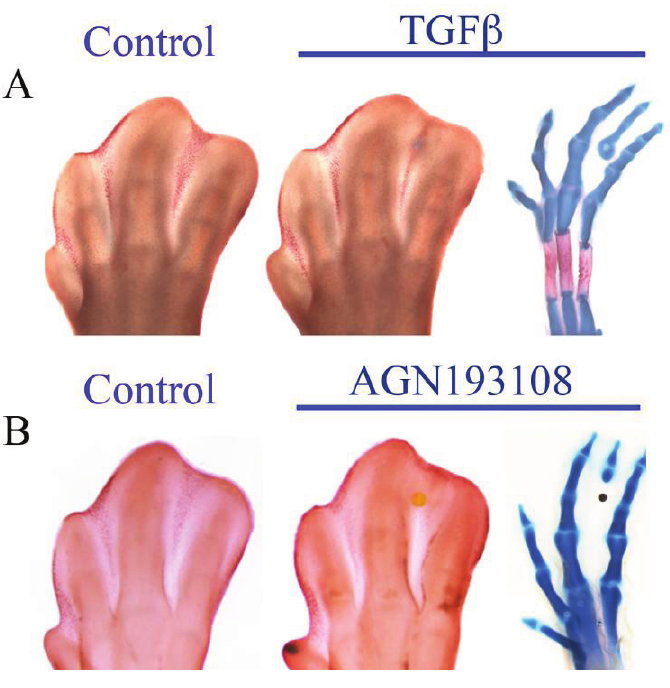
Figure 5. Activation of transforming growth factor beta ( TGFβ ) signaling or inhibition of RAR inhibits interdigital cell death and induces the formation of an ectopic digit. ( A ) TGFβ or ( B ) pan-RAR antagonist (AGN193108) inhibits cell death and induces the formation of an ectopic digit after 4 days of treatment. The inhibition of RA signaling with a pan-RAR antagonist (AGN193108) gives rise to the same phenotype as treatment with TGFβ. For both treatments n eutral red staining indicates interdigital cell death. The image of the ectopic digit after TGFβ treatment was taken from